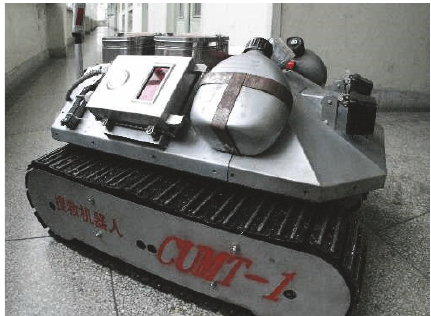
Figure 1: CUMT-1, the first generation of coal mine disaster rescue robots in China University of Mining and Technology.